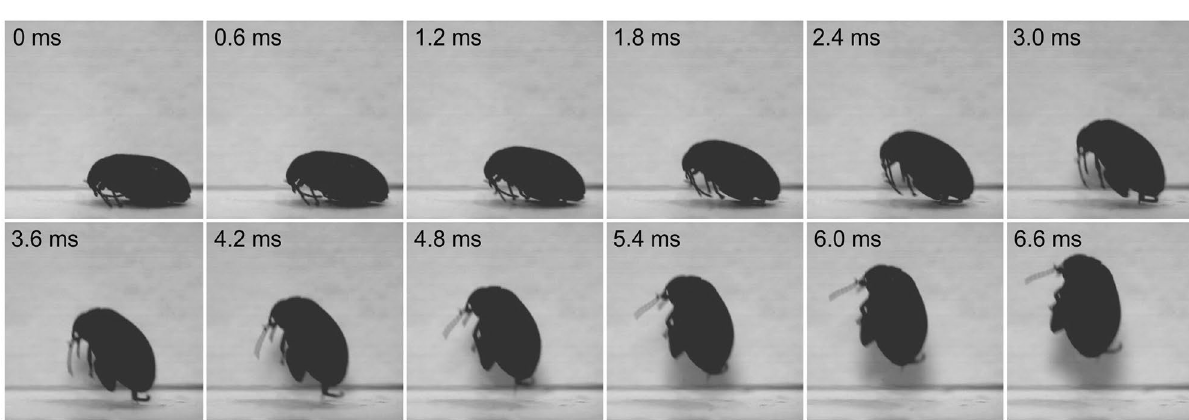
Figure 6. Frame-by-frame depiction of the jump of the marsh beetle Scirtes hemisphaericus . Jump is elicited by one hind legs, 3000 frames s −1